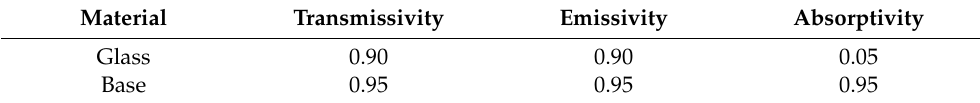
Table 2. Relevant properties of the SDCPP